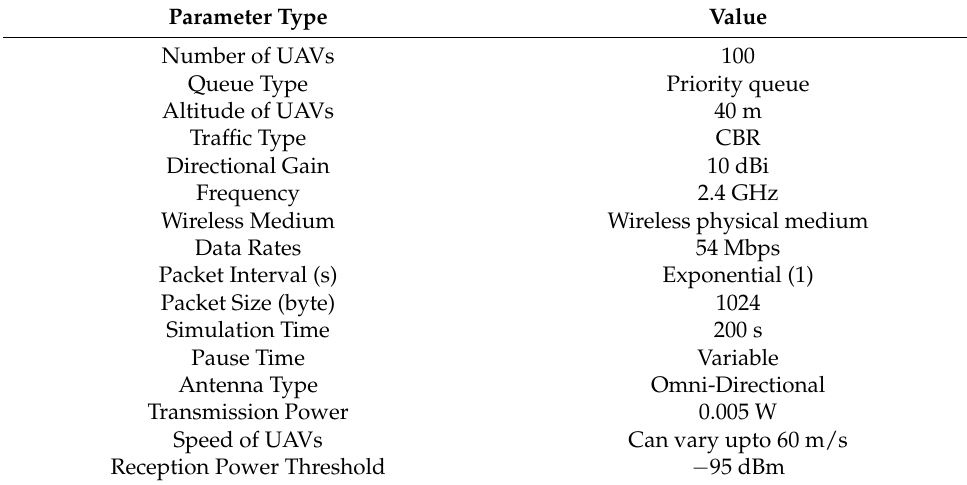
Table 4. Characteristics of